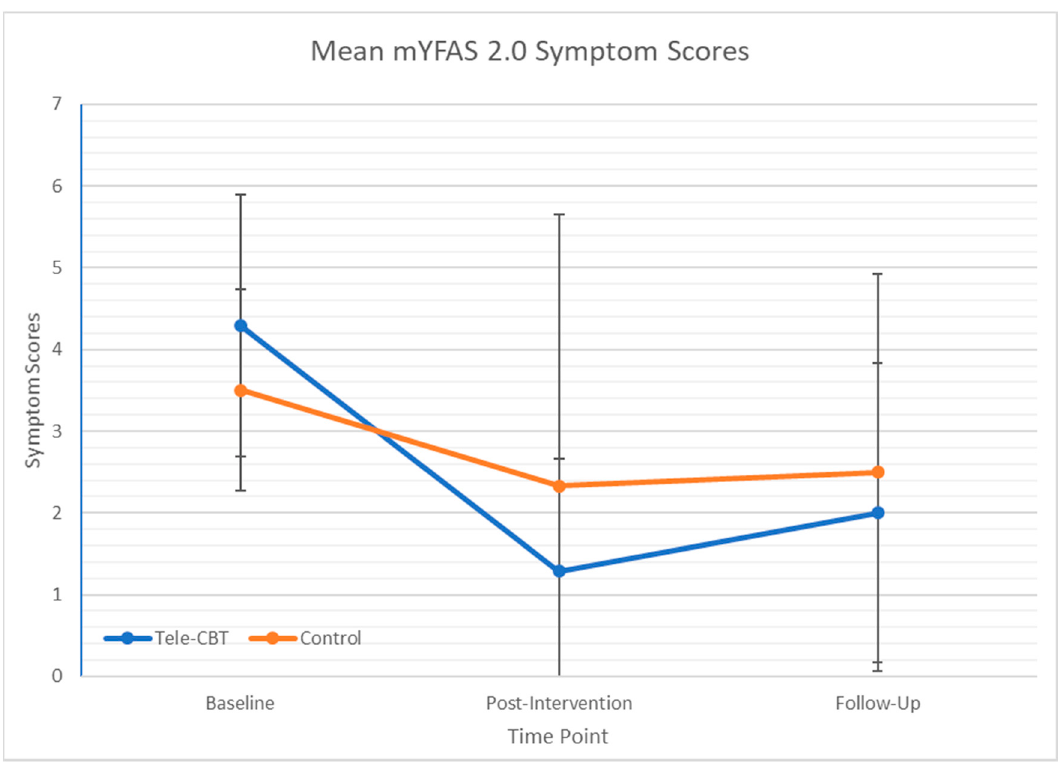
Figure 1. Changes in mYFAS 2.0 symptom scores over time as a function of treatment group among patients meeting “diagnosis” for food addiction at 1 year post-surgery ( n = 13). Note: Baseline = 1 year post-surgery (prior to CBT); Post-intervention = 15 months post-surgery (immediately following CBT); Follow-up = 18 months post-surgery (3 months following CBT). mYFAS 2.0 Symptomatology—Modified behavioural